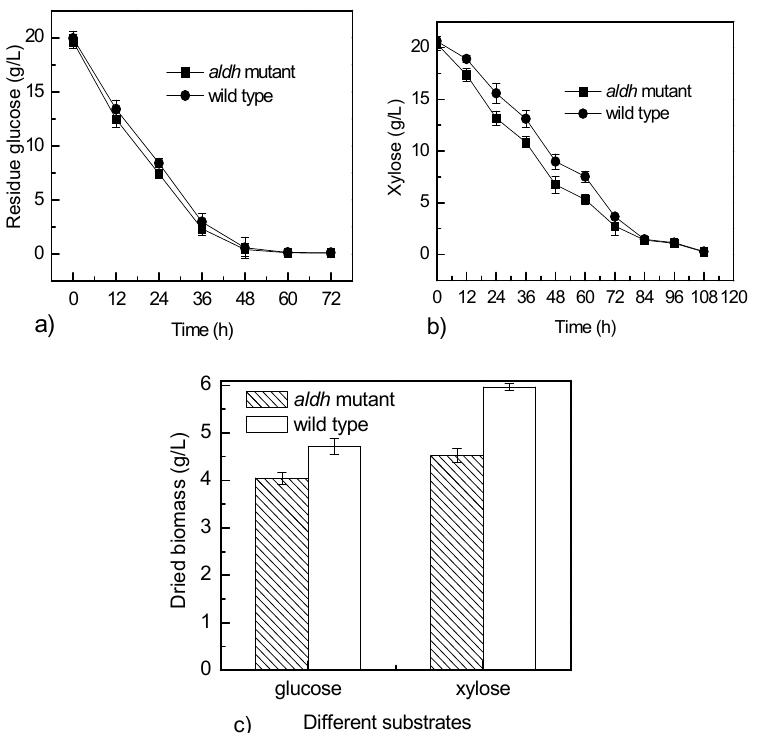
Figure 6. Xylose and glucose utilization and cell growth profile for F. oxysporum strain cs28 and mutant strain cs28pCAM-Pstal- ∆ aldh . Cells were cultured in 50 mL of fermentation medium with 20 g/L of glucose ( a ) and 20 g/L of xylose ( b ), and dried biomass was weighed at 105 °C for 4 h ( c ). Symbols: ● : wild-type strain cs28; ■ : aldh mutant strain cs28pCAM-Pstal- ∆ aldh ; □ : wild-type strain cs28; ▧ : aldh mutant strain cs28pCAM-Pstal- ∆ aldh .